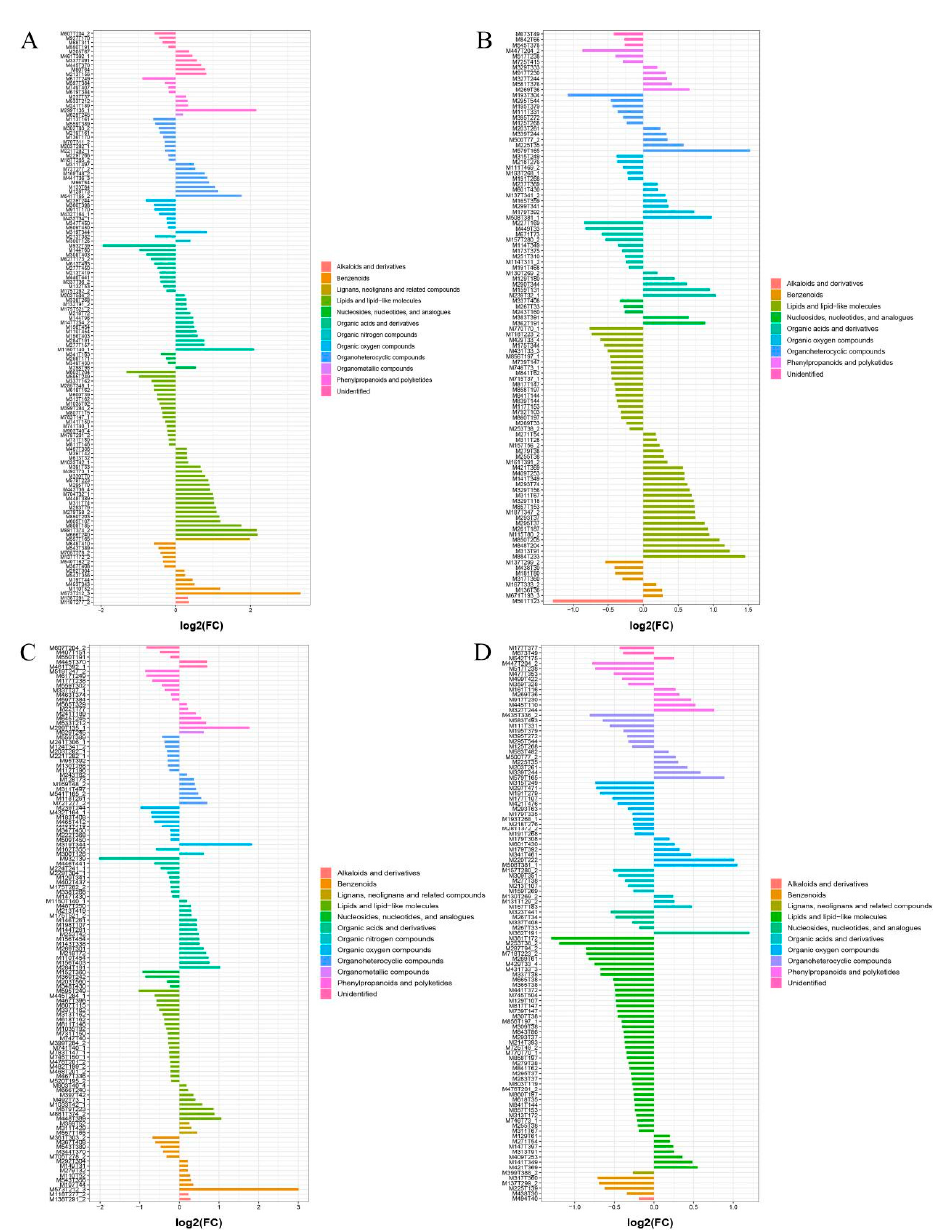
Figure 6. Classes of significantly different metabolites in different sources of YCH. ( A , B ) The fold-change histograms of significantly different metabolites between Wild and Cultivated I in the positive and negative ion mode, respectively. ( C , D ) The fold-change histograms of significantly different metabolites between Wild and Cultivated II in the cation and anion modes, respectively.